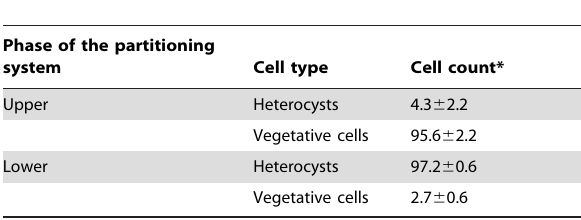
Table 1. Heterocyst and vegetative cell enrichment